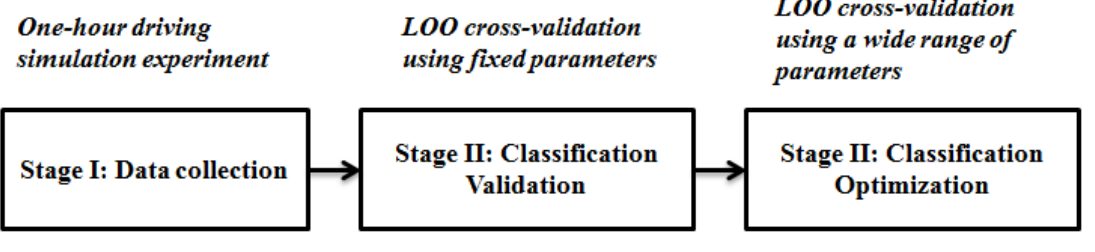
Figure 3. The classification model building chain containing three different tasks: data collection, classification validation and classification